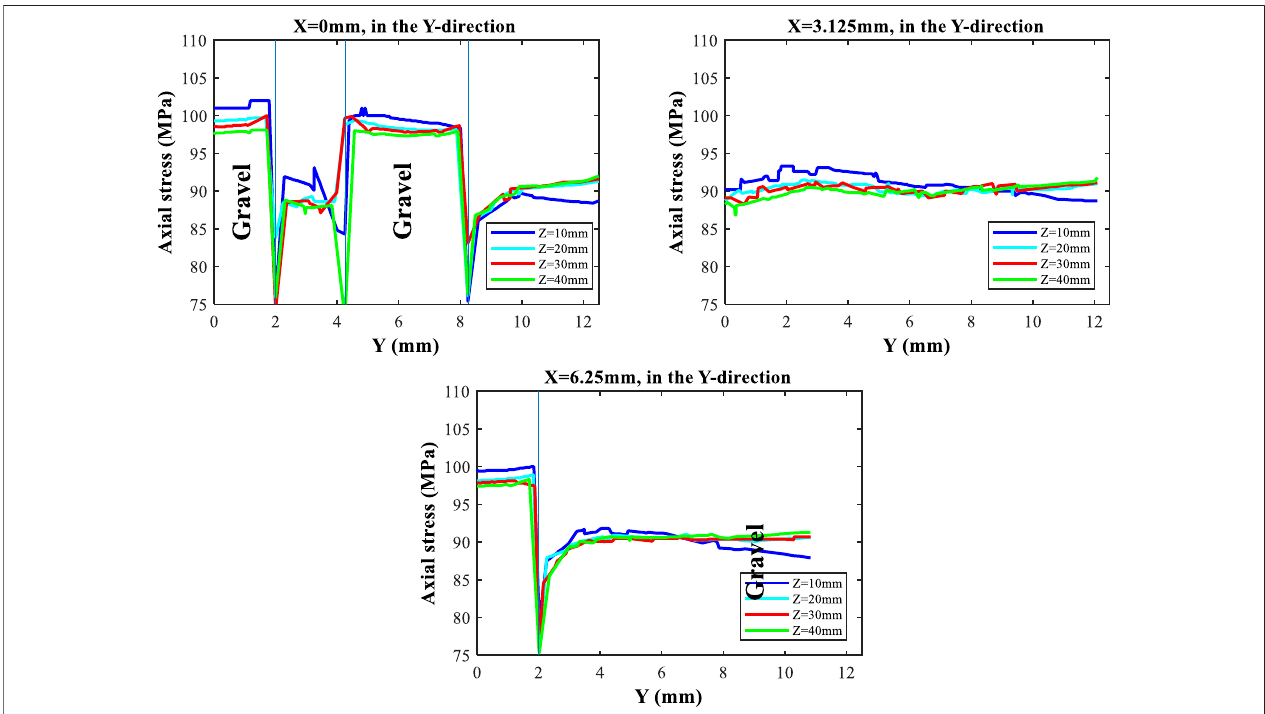
FIGURE 11 | Distribution of axial stresses at X (cid:2) 0, 3.125, and 6.25 mm in the Y-direction in planes of Z (cid:2) 10, 20, 30, and 40 mm in the base case. Vertical lines denote the gravel-matrix interfaces.